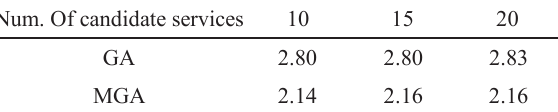
Table 5. Time comparisons of GA and MGA (a) Comparisons with n =10 varying m Num. Of candidate services